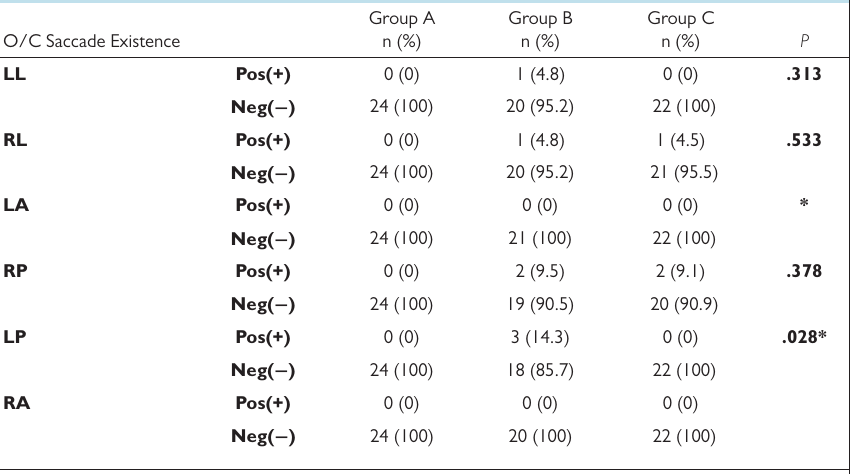
Table 6. The Evaluation of LL, RL, LA, RP, LP, and RA Parameters in Groups with Respect to O/C Saccade Existence O/C Saccade